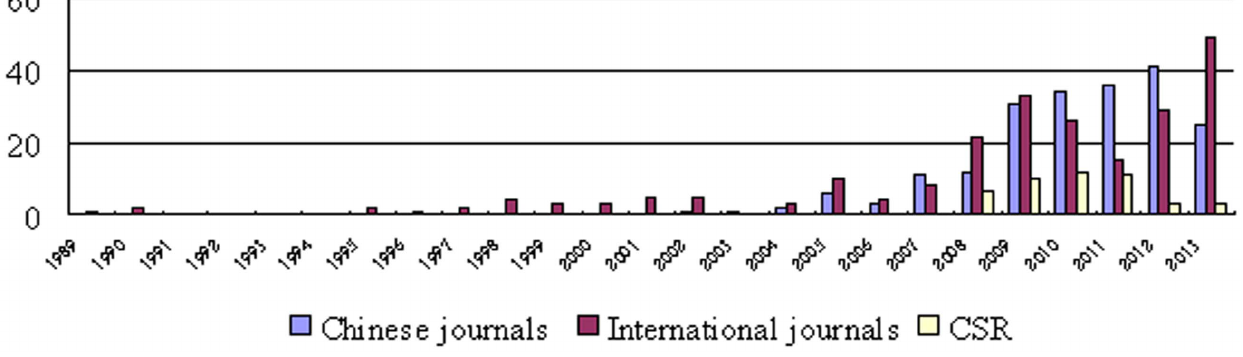
Figure 2. The number of included SRs MAs on acupuncture.